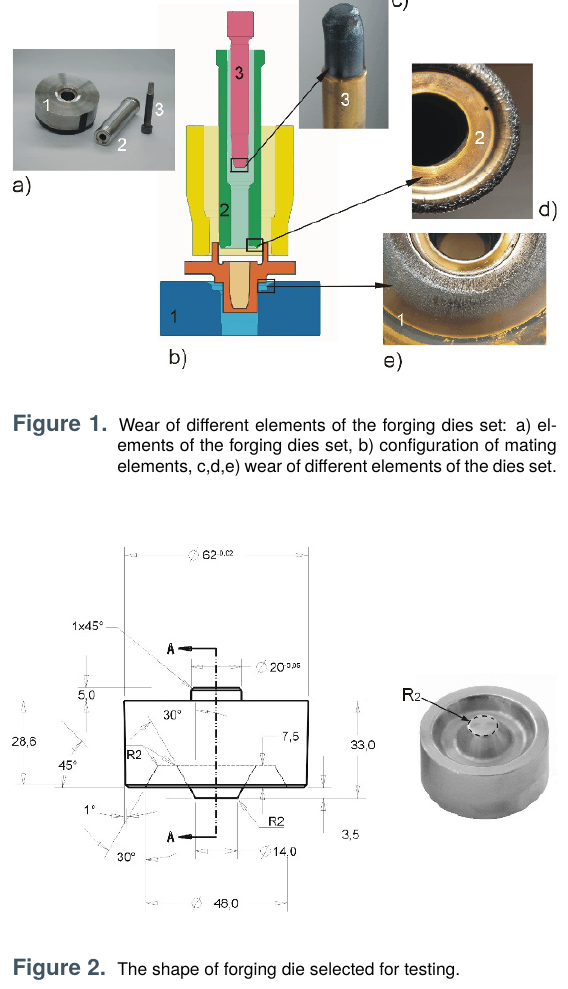
Figure 2. The shape of forging die selected for